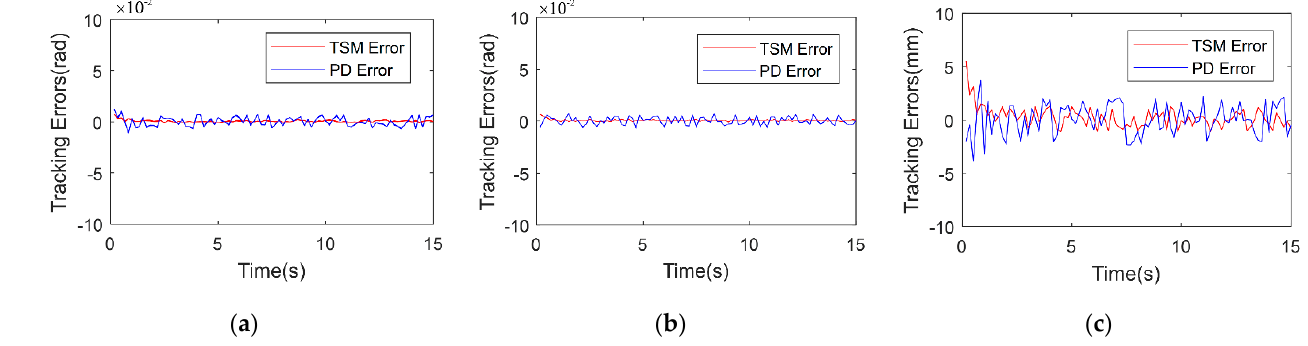
Figure 9. Trajectory tracking variance mean square. ( a ) RMSE of TSM-based controller trajectory tracking. ( b ) RMSE of Trajectory tracking based on PD controller.